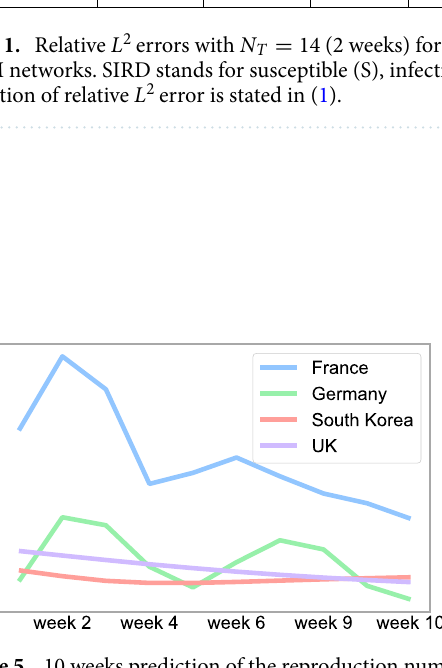
Figure 5. 10 weeks prediction of the reproduction number, R 0 , using β generated by the LSTM network for each